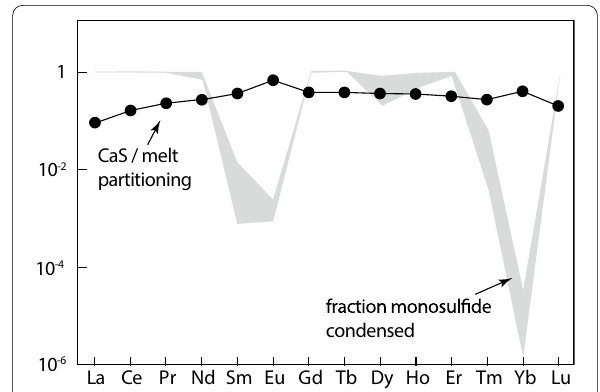
Fig. 1 Rare-Earth Element pattern (in grey) predicted by modeling condensation as monosulfides solid solution in oldhamite [CaS, Lodders and Fegley (1993)]. Conditions are T oldhamite condensation temperature) and a nebular gas with C/O 1.2 (reduced conditions). Also shown are the CaS/melt REE = partition coefficients determined experimentally by Ingrao et al.